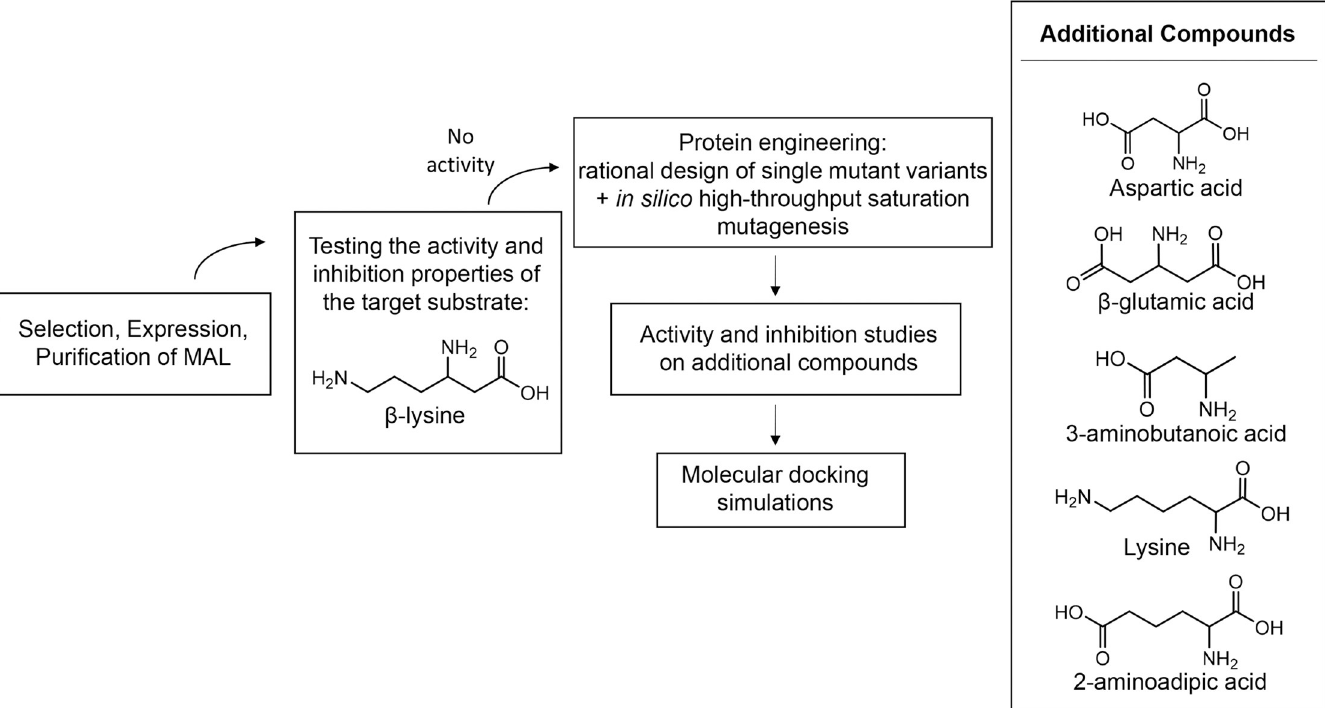
Fig 2. Strategies and workflow employed in the present study. The activity and inhibition of three different MALs on the target substrate β -lysine was assayed. A protein engineering strategy combining rational design with an in silico high-throughput saturation mutagenesis method was then used to design and test five single- mutant variants of CaMAL. Finally, molecular docking, and activity and inhibition assays were carried out in additional substrates in order to characterize the molecular requirements for the substrate binding in MAL.